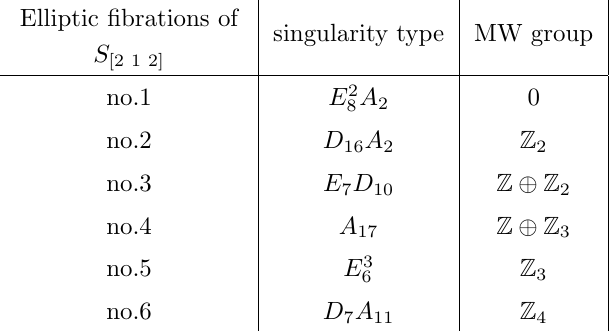
, singularity types of the (cid:12)brations, [2 1 2]